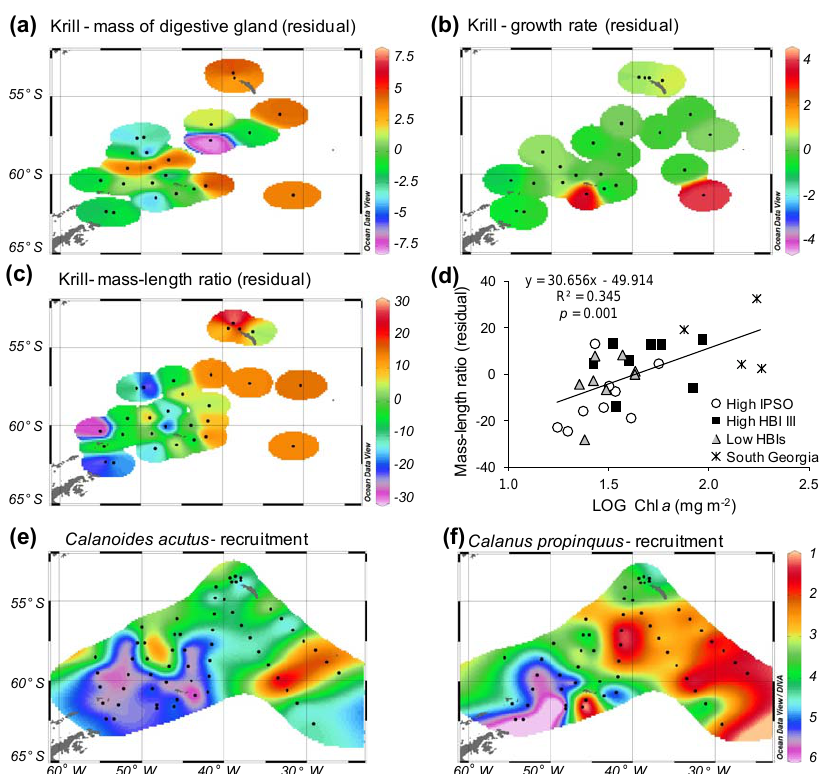
Figure 8. Local differences in the performance of krill ( Euphausia superba ) and large calanoid copepods ( Calanoides acutus , Calanus propinquus ) as indicated by their body reserves, growth and recruitment. To account for differences in krill body length, residuals rather than absolute values are presented. Residuals were calculated as positive or negative deviations from the relationship between the index of body condition ( y ) and krill length ( x ). Positive values denote “above-average” body conditions for their size, while negative values suggest “below-average” body conditions. (a) Residual of the mass of the digestive gland. y = 85 . 234 x + 2 . 5386; R 2 = 0 . 7271, n = 25. (b) Residual of the krill growth rate in mass, based on original data from Atkinson et al. (2006). y = 65586 x − 3 . 069 ; R 2 = 0 . 3265, n = 24. (c) Residual of the krill mass–length ratio. y = 0 . 0016 x 3 . 2479 , R 2 = 0 . 8627, n = 29. (d) Overall linear regression between the residuals of the krill mass– length ratio (panel c ) and the availability of food, indicated by the integrated chl a concentration in the upper 100m water column. Krill from different locations are distinguished by their IPSO 25 - or HBI III content: “high IPSO 25 ” (>30ngg − 1 ) , “high HBI III” (>100ngg − 1 ) , “low IPSO 25 and HBI III” (<100ngg − 1 ) and “South Georgia” (<100ngg − 1 ) . Each symbol represents 3–15 pooled individuals of the same body length. (e) Recruitment of Calanoides acutus . (f) Recruitment of Calanus propinquus . To calculate the mean age of the population, six copepodite stages of increasing age were considered: first, second, third, fourth, fifth and sixth. Low numbers indicate a young age of the population, dominated by new recruits (stage 1–3). Late copepodite stages (stage 5-6) represent the old, overwintered